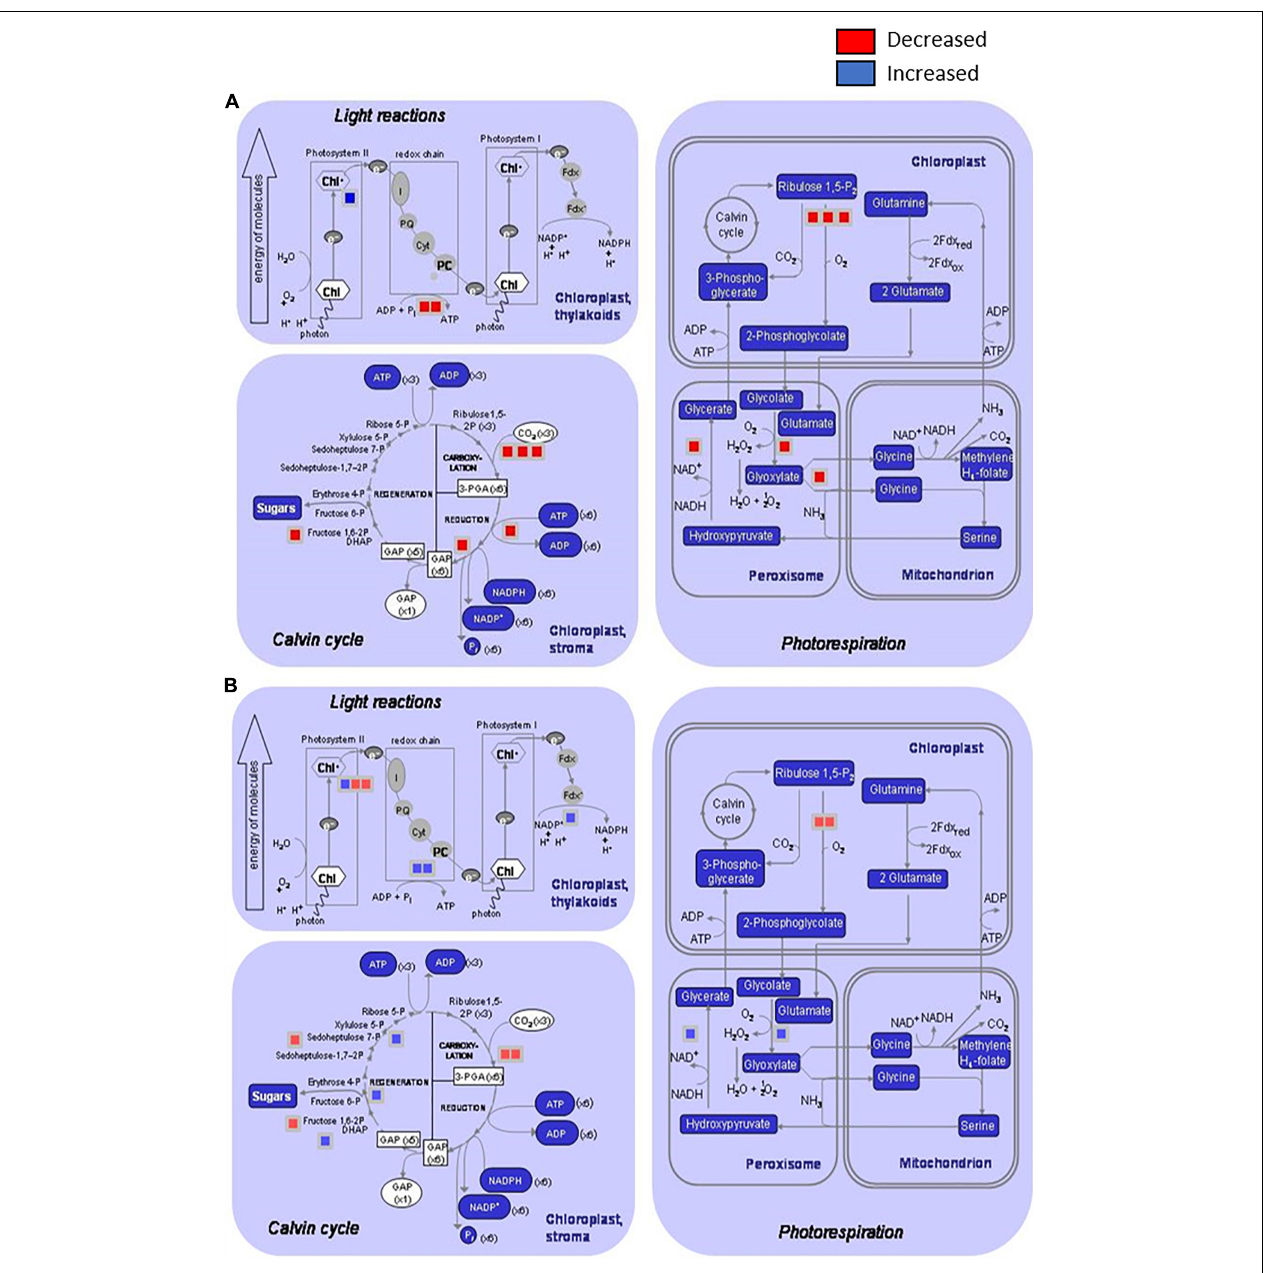
FIGURE 2 | Distribution of the differentially induced proteins involved on primary metabolism processes after infection of Brassica oleracea leaves by Xanthomonas campestris pv. campestris . Graphics show proteins decreased or increased in three processes: light reactions (photosystem I, Photosystem II, and redox chain), Calvin cycle, and photorespiration (in chloroplast, peroxisomes, and mitochondrions) by using the MapMan software. (A) 3 dpi and (B) 12 dpi. Red square: downregulated protein; blue square: upregulated protein. At 3 dpi, two proteins involved in light reactions, six proteins in Calvin cycle, and six proteins in photorespiration were significantly reduced in infested plants versus control plants. Only one protein involved in Photosystem II was significantly increased at this stage. At 12 dpi, two proteins involved in Photosystem I, four proteins related to Calvin cycle, and two proteins involved photorespiration in chloroplasts were significantly reduced in infested plants versus control plants. Protein induction was stronger at 12 dpi than 3 dpi, and four proteins related to light reactions, three involved in Calvin cycle and two proteins involved in photorespiration at peroxisome level were differentially